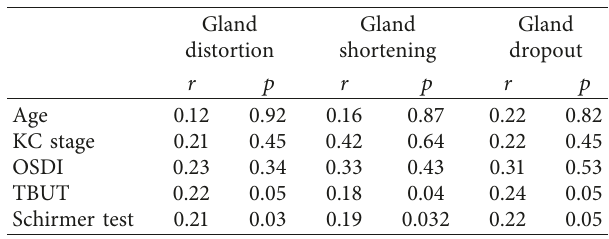
Table 5: Correlation between the meibomian gland characteristics in meibography and other factors in KC